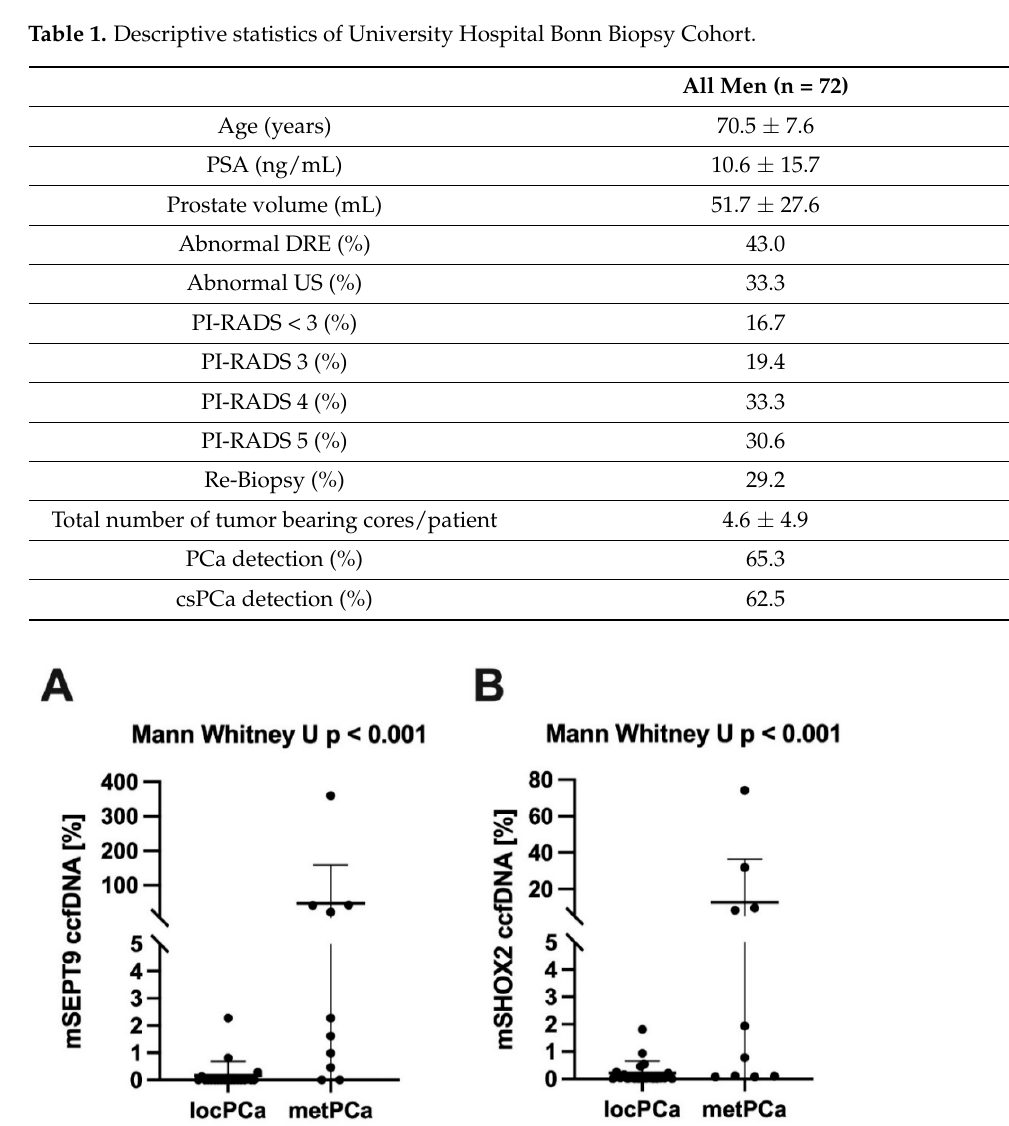
Table 1. Descriptive statistics of University Hospital Bonn Biopsy Cohort.